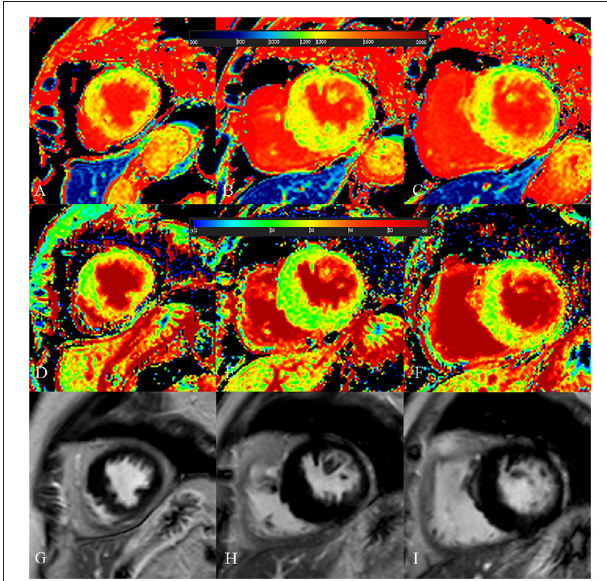
FIGURE 5 | A 73-year-old female with focal midseptum hypertrophic cardiomyopathy. (A – C) Native T1 mapping of the apical, mid-, and basal